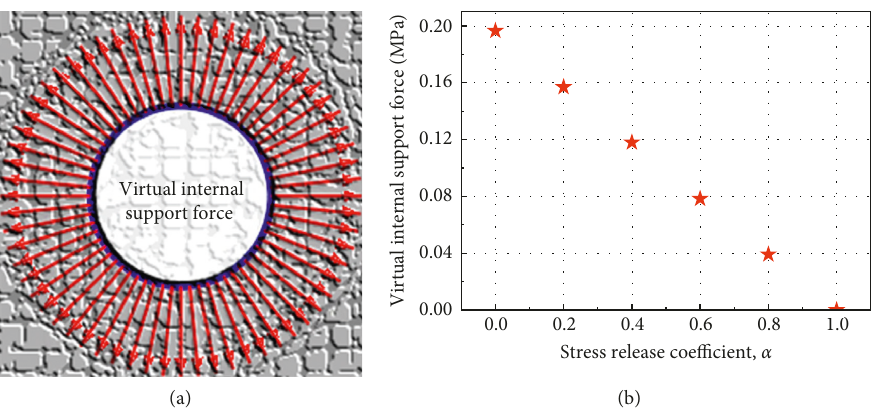
Figure 6: Virtual internal force diagram and different stress release values. (a) Virtual internal support force. (b) Virtual internal support force corresponding to different stress release